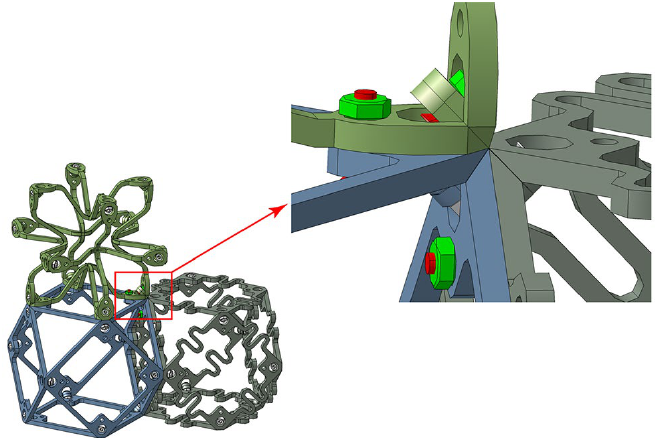
Figure 19. Schematic diagram the screw connection between several cells.